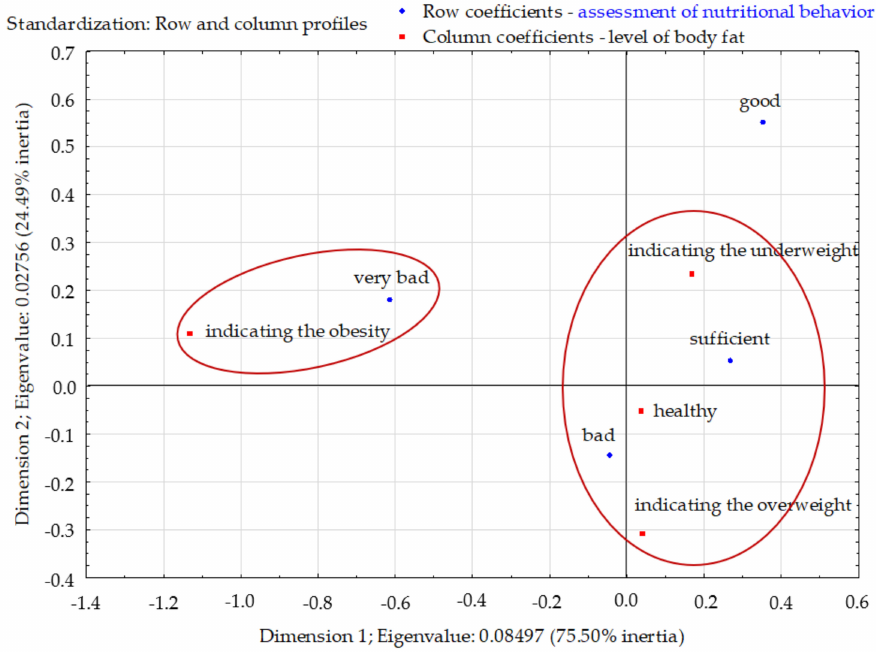
Figure 5. Assessment of the nutritional behavior of young Poles and the level of body fat in the organism (correspondence analysis). Source: own study based on the